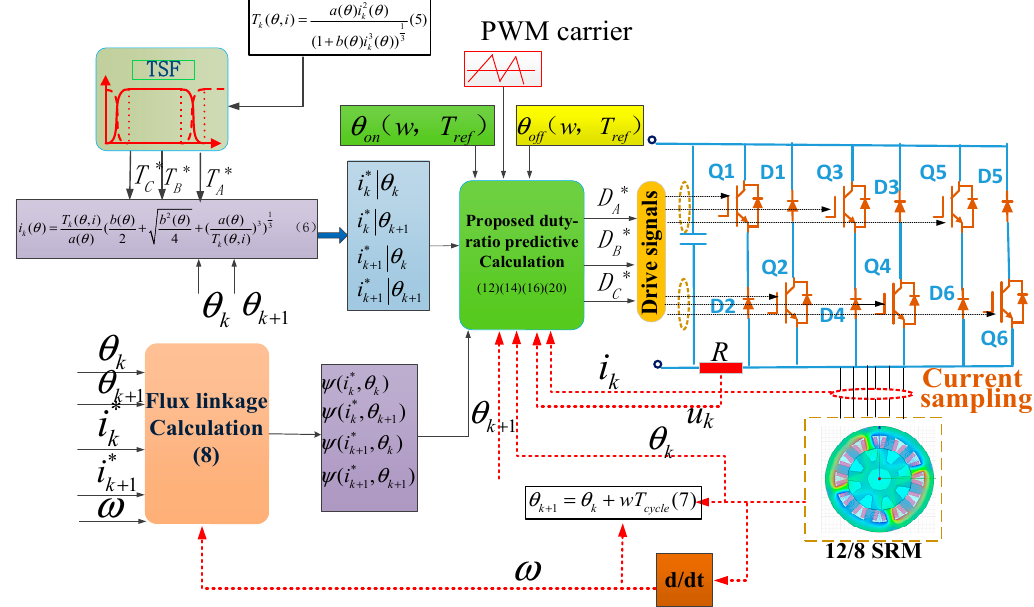
Figure 1. Block diagram of torque sharing function (TSF) based on the proposed current control method.